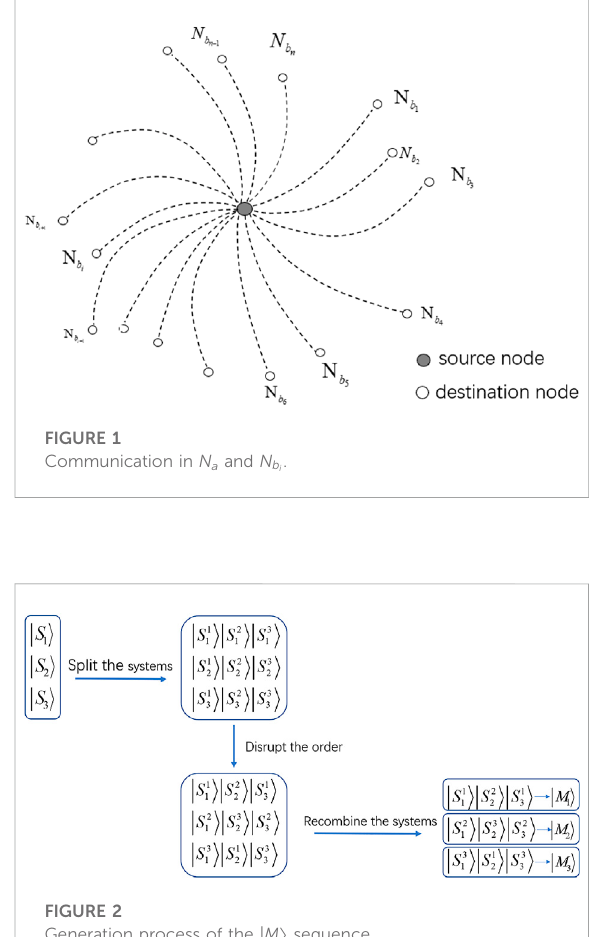
FIGURE 2 Generation process of the | M 〉